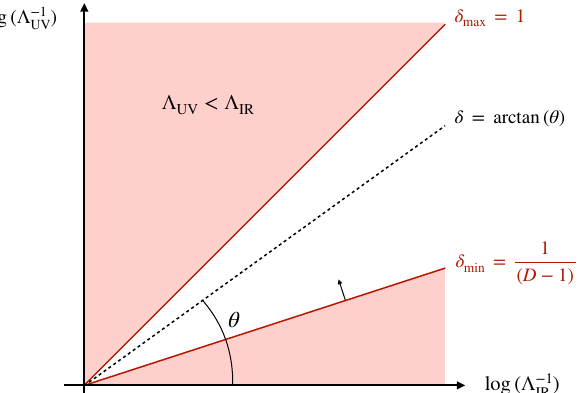
Figure 2 . The UV and IR cut-offs in log scale are related linearly. The BH entropy bound implies that there is a minimum slope δ min = 1 / ( D − 1)